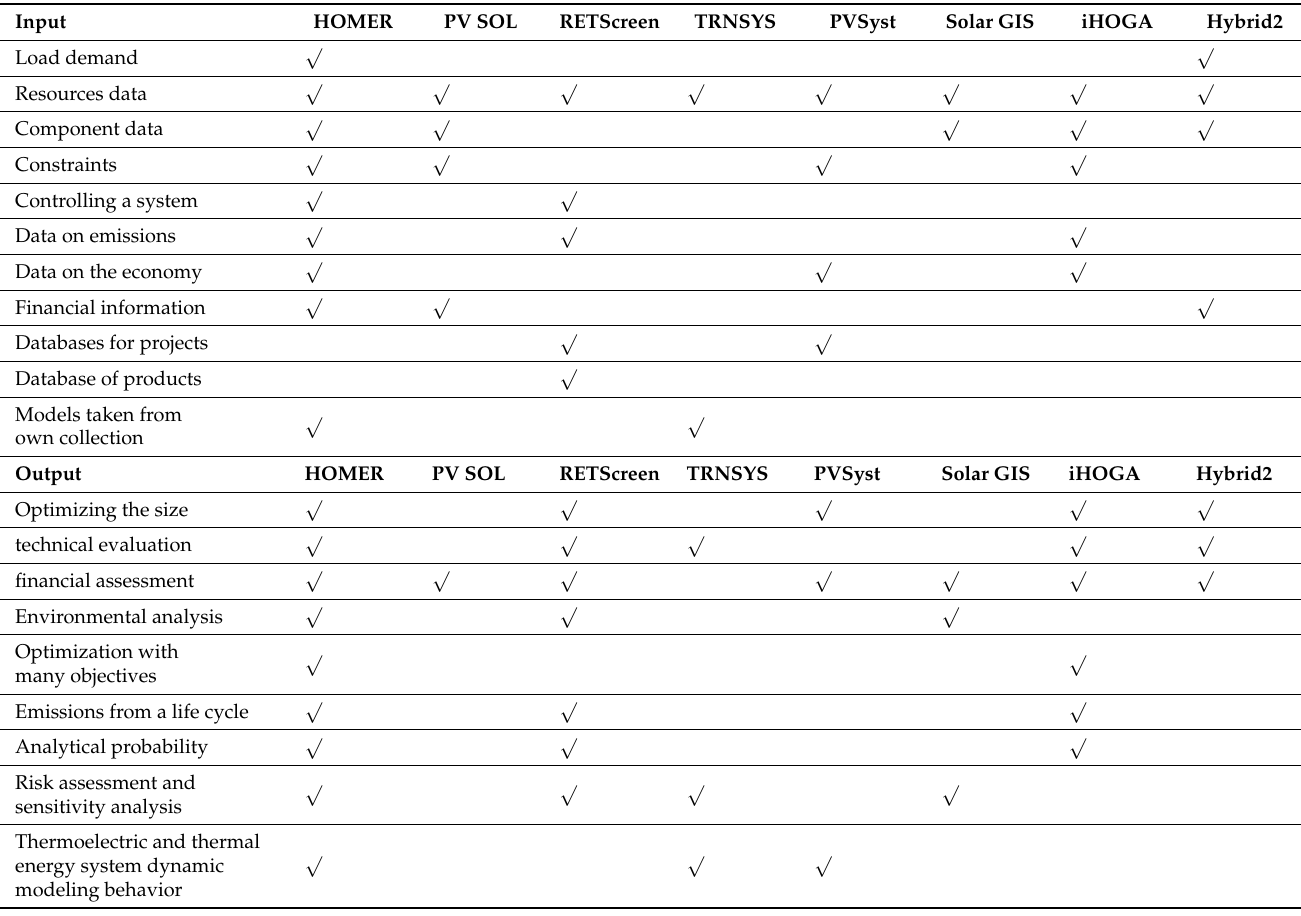
energy. Table 6 summarized the inlet and outlet attributes of each scaling tool as: Table 6. Sizing tool’s input and output